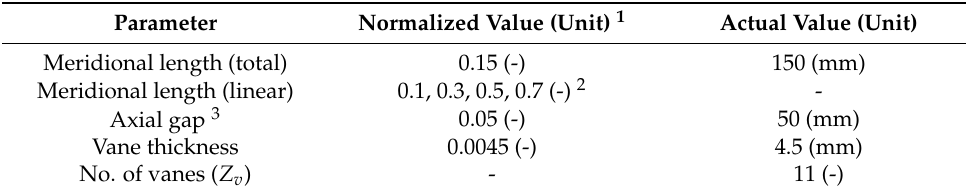
Table 3. Design parameters of the guide vanes.